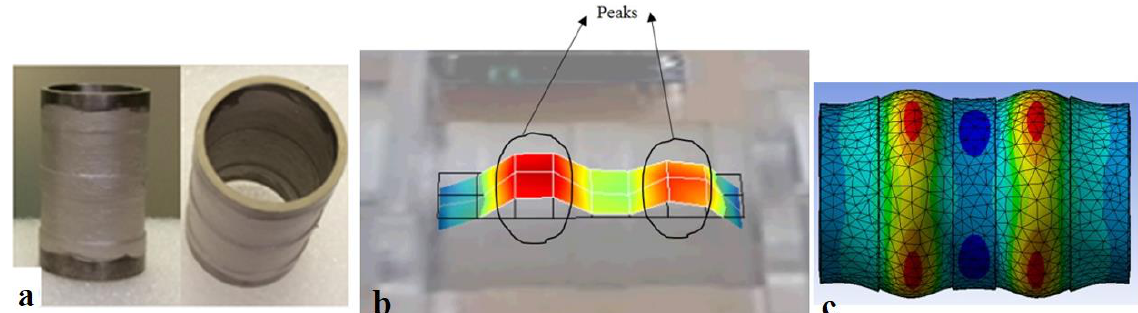
Figure 6. ( a ) Axially stepped-thickness transducer in two views; vibration mode shape with circum- ferential and axial wave numbers of zero and five, respectively: ( b ) Experimental; ( c ) Simulation [4].